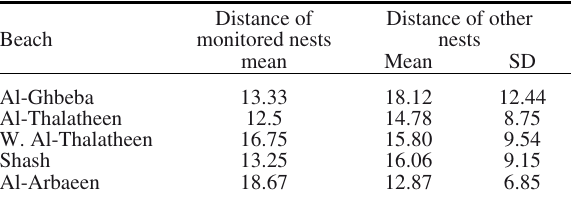
Table 1. – Distance from the wave line of studied nests in compari- son with all recorded nests at each nesting beach. Beach